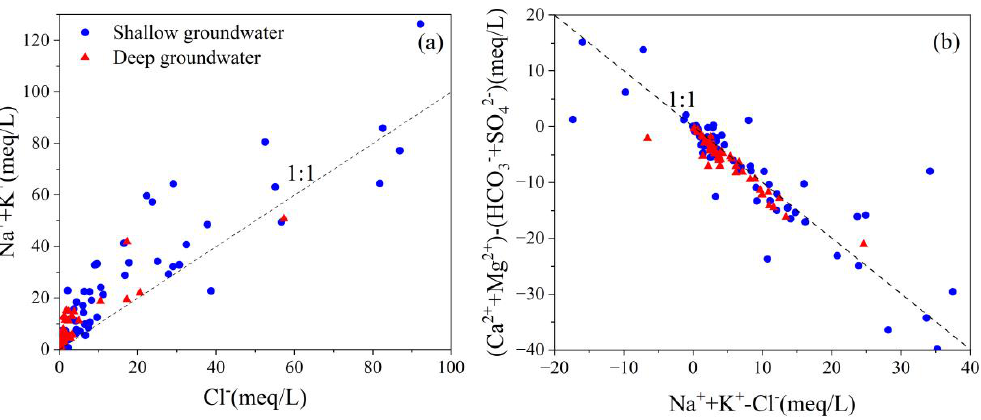
Figure 6. ( a ) (Na + + Ca 2+ ) mg/L vs. Cl − mg/L; ( b ) (Ca 2+ + Mg 2+ )-(SO 4 2 − − HCO 3 − )meq/L vs. (Na + + K + − Cl − )